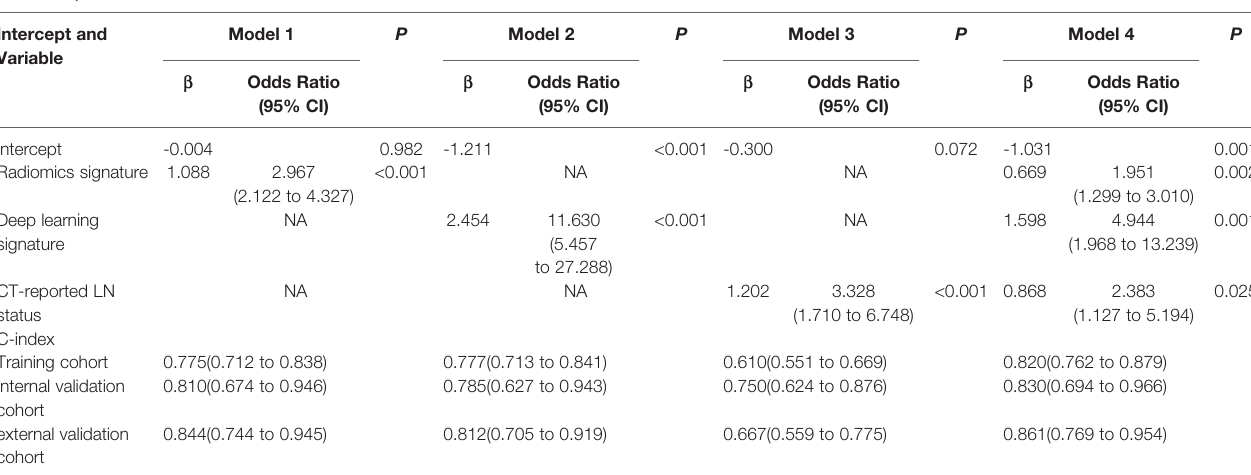
TABLE 2 | Risk factors for LN metastasis in